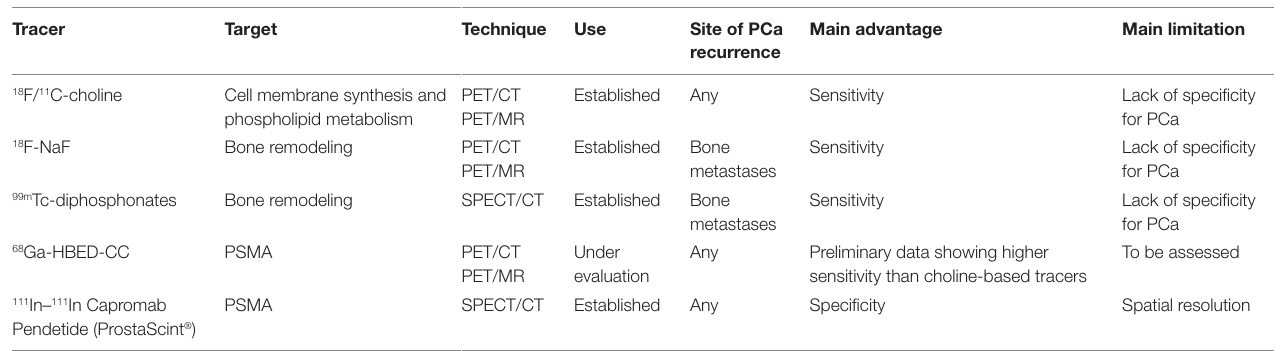
TABLe 1 | Summary of the most relevant tracers available for the evaluation of recurrent PCa. Tracer Target Technique Use Site of PCa